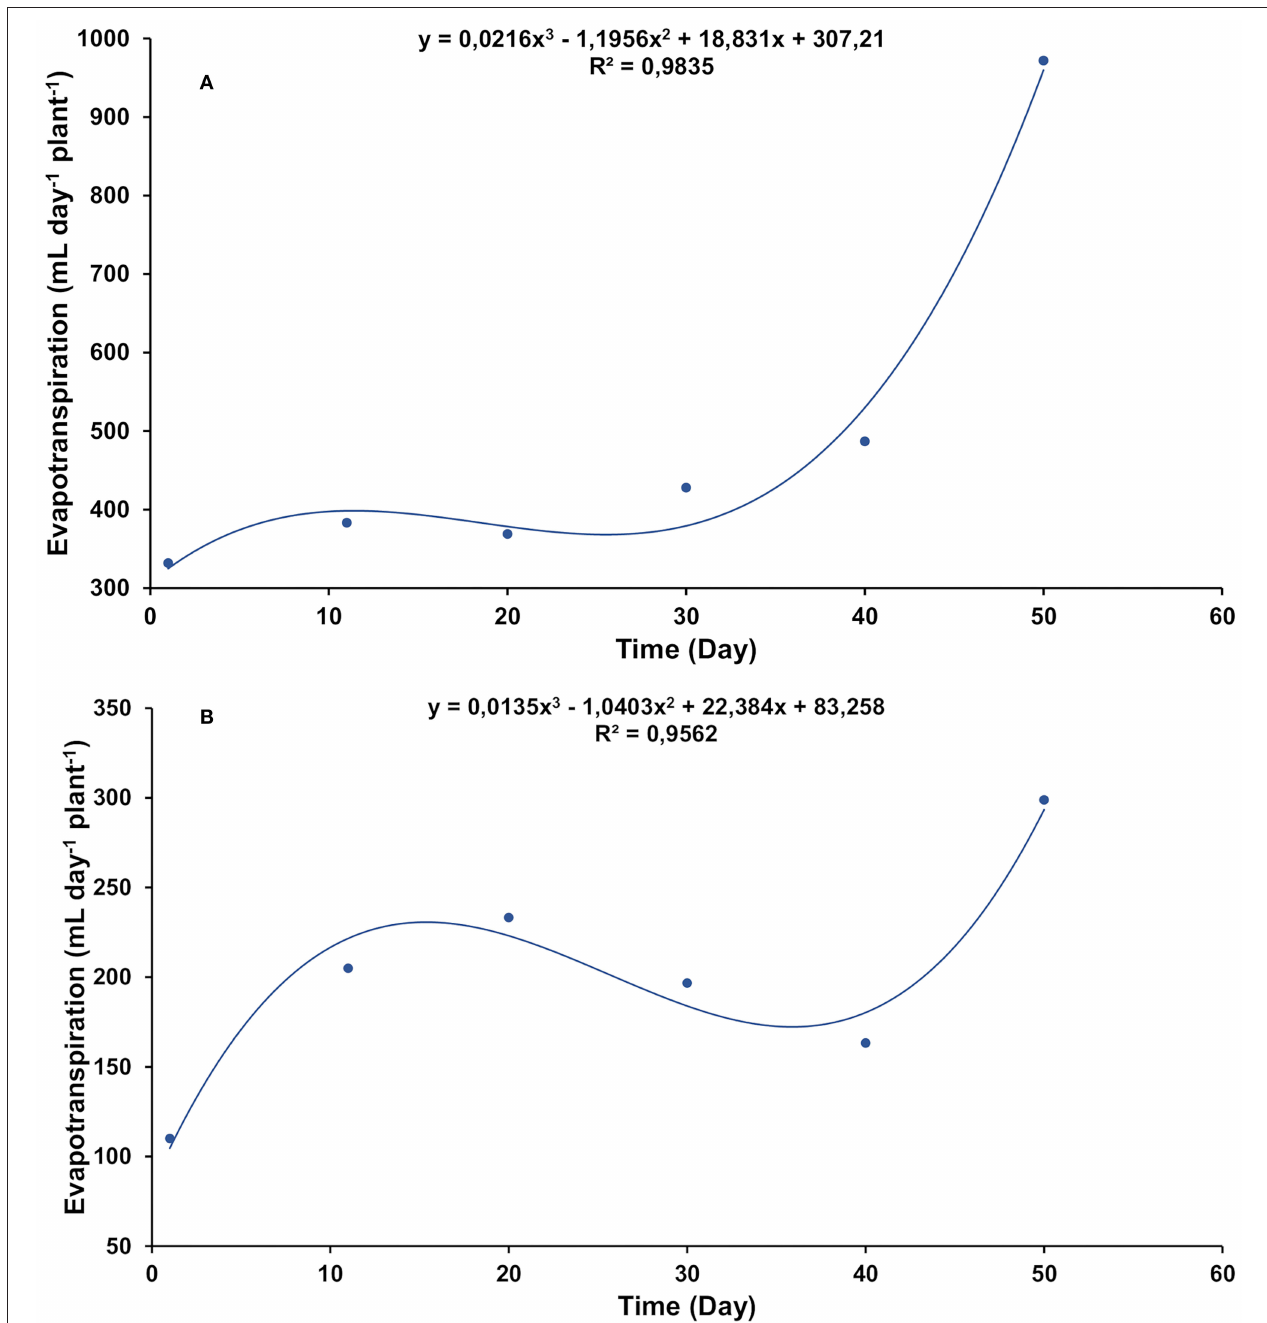
FIGURE 1 | Daily evapotranspiration rate in gliricidia plants at 0.0 (A) and 0.8 (B) g of NaCl per 100g of the substrate. The values represent the average of 11 replicates, in a timeline starting from 1 day up to 50 days of treatment.